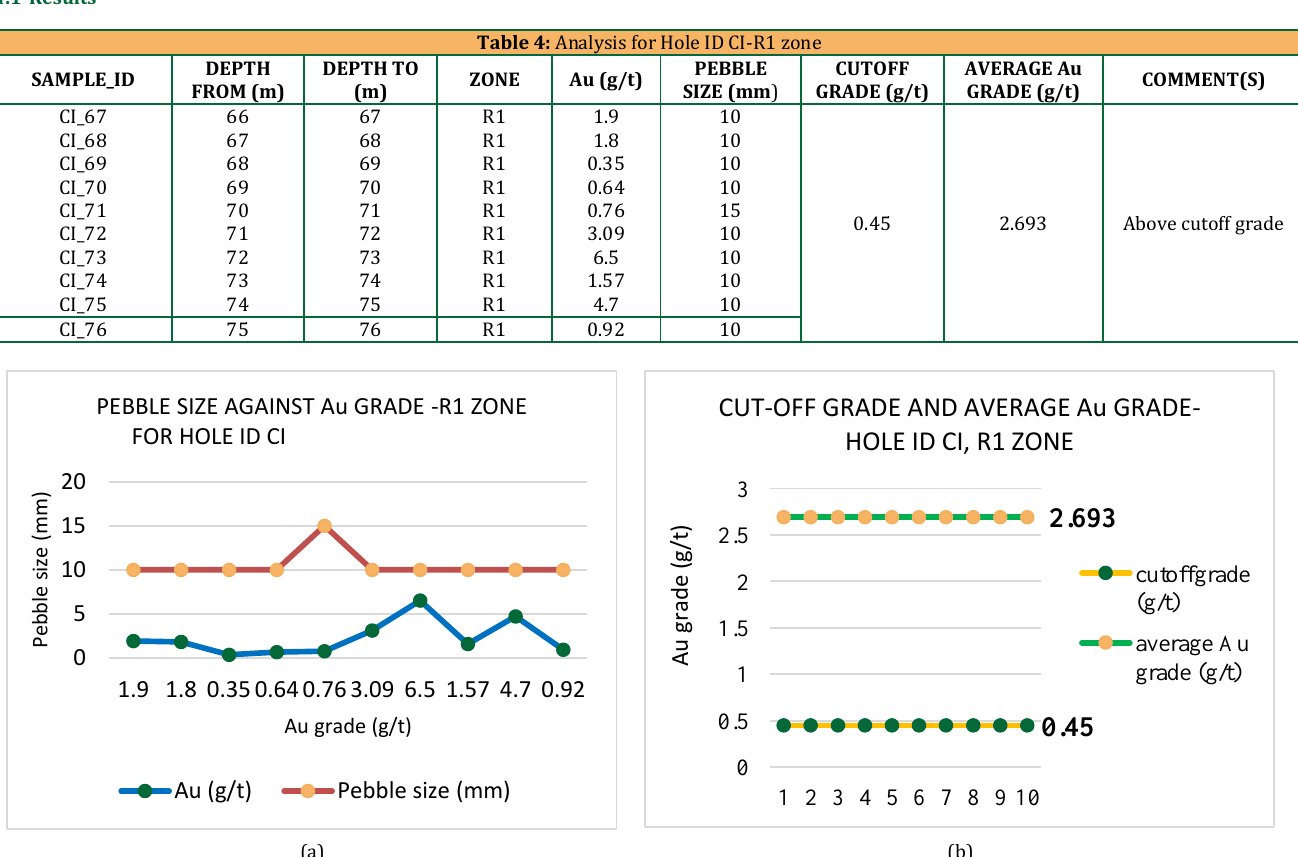
Figure 3: (a) Au grade against pebble size-R1 zone; (b) Cutoff grade and average Au grade - Hole ID CI, R1